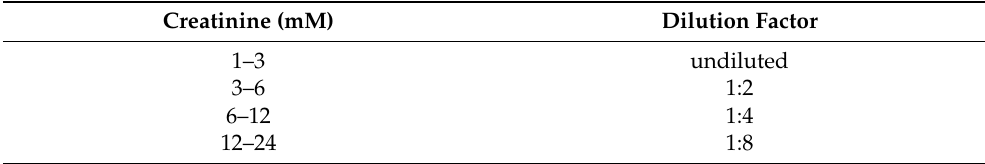
Table 1. Dilution of urine samples based on creatinine